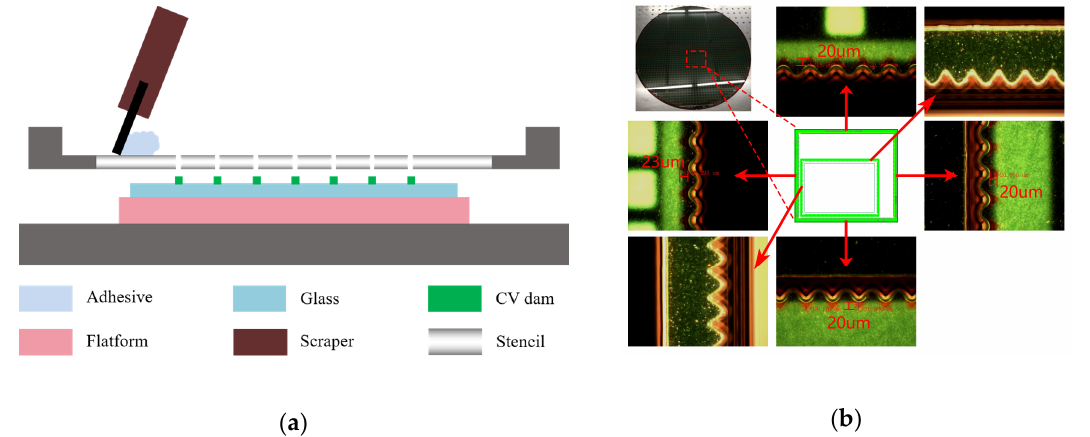
Figure 10. ( a ) Schematic of adhesive glue stencil print; ( b ) Adhesive glue control within CV dam tooth.